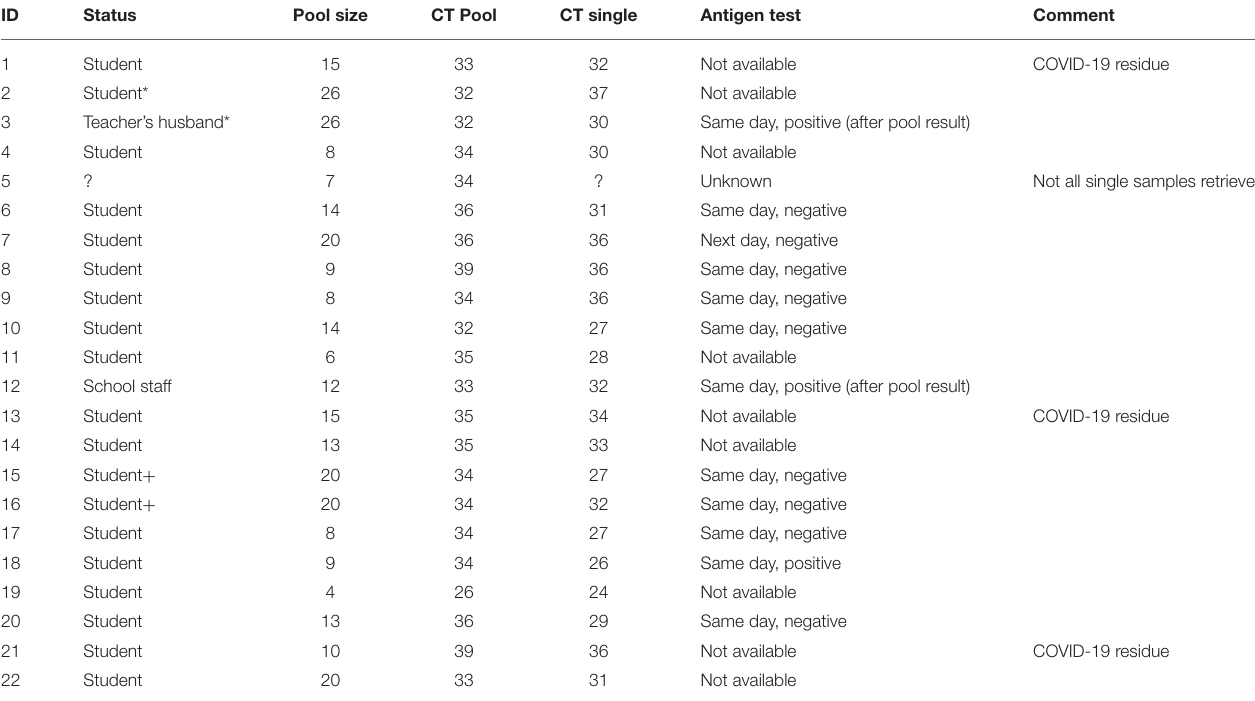
TABLE 2 | Characteristics of positive pools and positive individuals in the WICOVIR